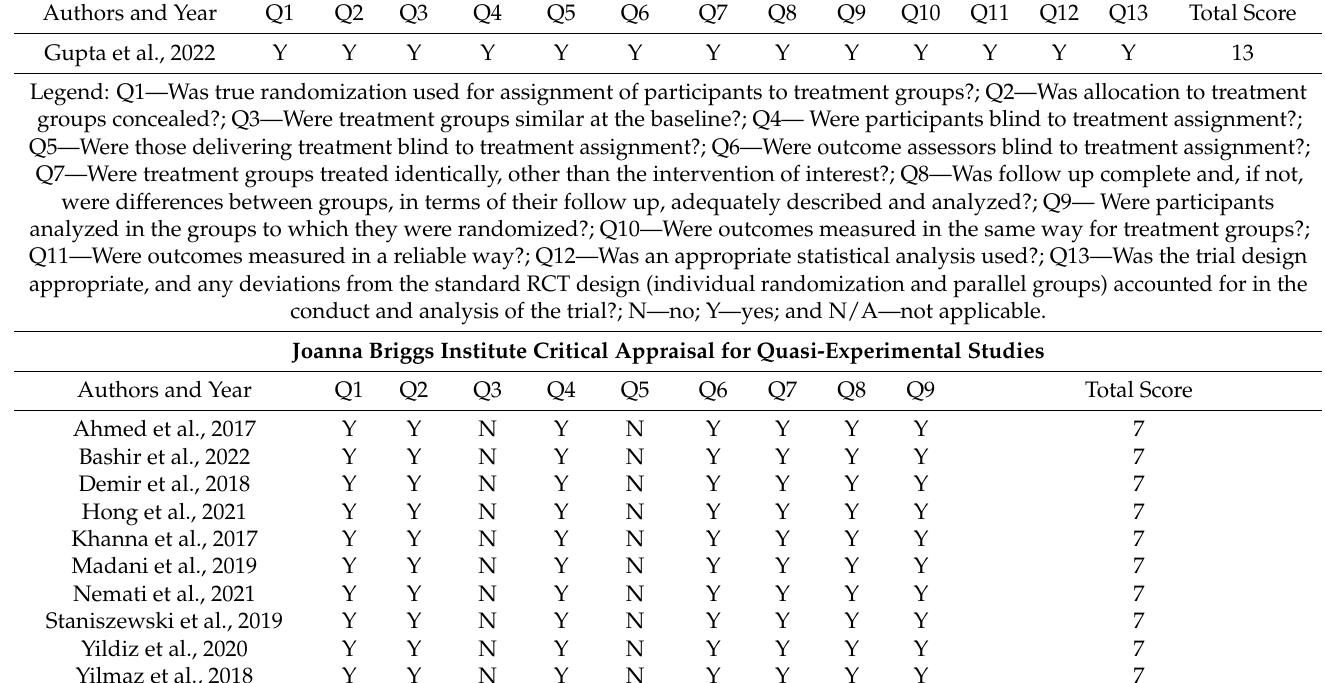
Table 3. Joanna Briggs Institute Critical Appraisal Checklist for the studies included. Joanna Briggs Institute Critical Appraisal Checklist for randomized controlled